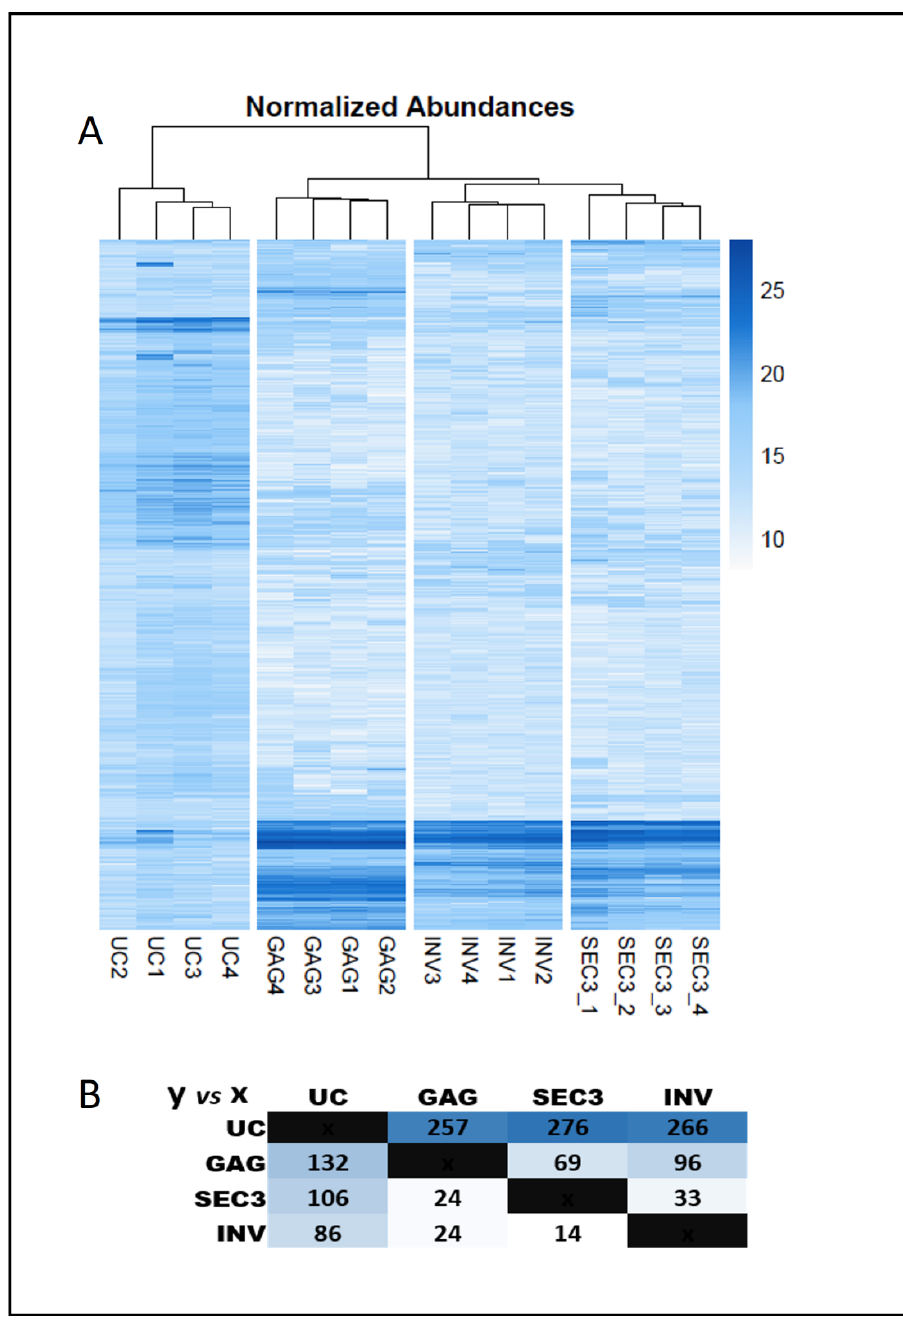
Figure 3. Differences in the proteomic profile enrichment achieved by each technique. ( A ) Unsupervised heatmap of normalized intensity values for each technique and identified protein. The color intensity correlates with the value of normalized abundance. ( B ) Proteins significatively enriched for each technique (sense of the comparison y axe vs. x axe) according to ANOVA and Tukey’s post hoc analysis (significance is considered for p value < 0.05, n = 4). The color intensity correlates with the number of molecules enriched.